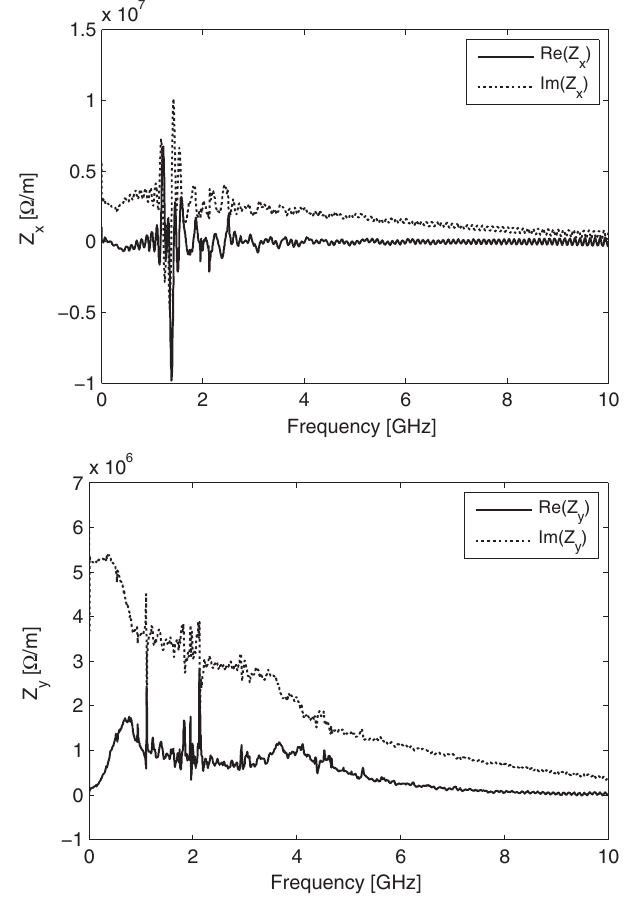
FIG. 13. Imaginary part of the vertical effective impedance as a function of vertical chromaticity at different energies. At injection energy (below transition) the machine operates at negative